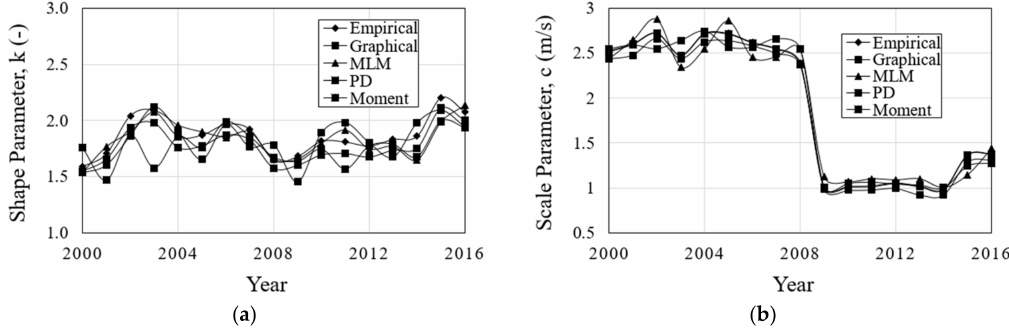
Figure 7. Estimations of the Weibull parameters at the test site using predicted data: ( a ) Shape parameter; ( b ) Scale parameter. MLM: maximum likelihood method; PD: power